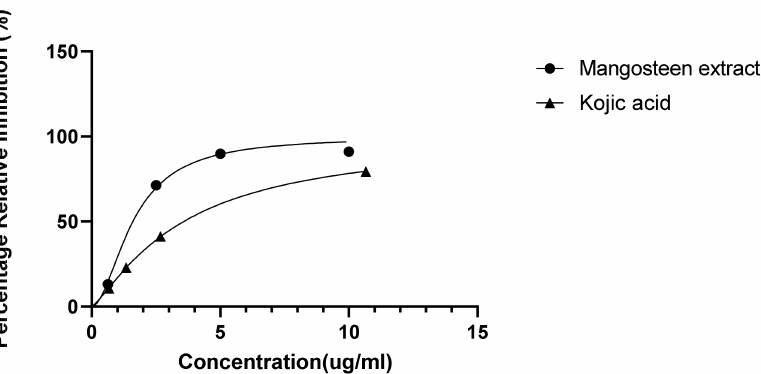
Figure 4. Tyrosinase inhibitory activity of mangosteen peel extract and kojic